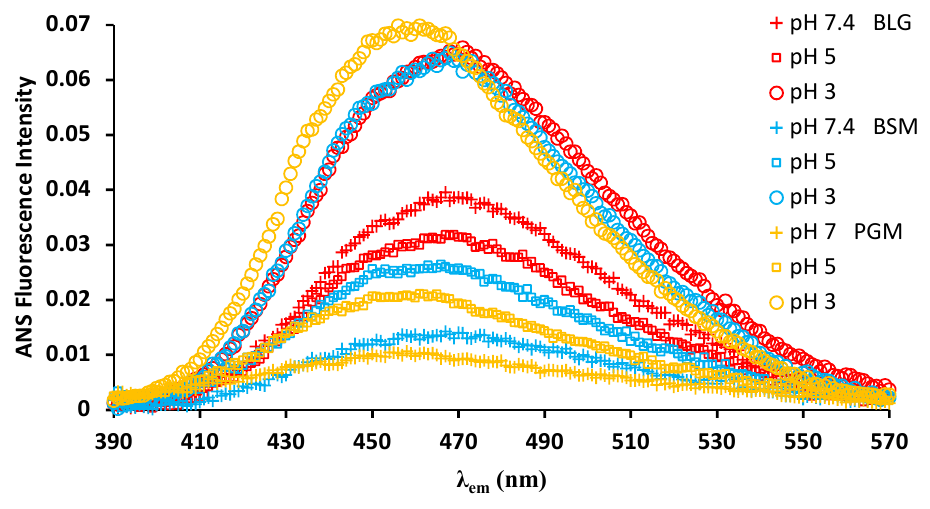
Figure 6. pH dependent fluorescence emission spectra of ANS binding proteins (BLG, BSM, PGM) at pH 7.4, pH 5, and pH 3. (Excitation wavelength: 365.5 nm).